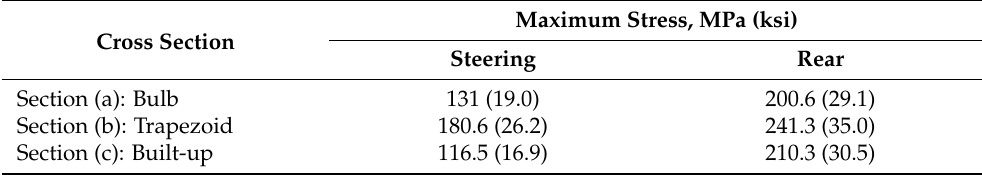
Table 3. Plane Strain Analysis Comparisons.